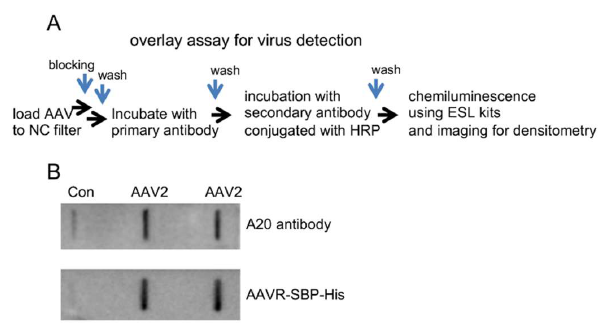
Figure 4. AAVR-SBP-His proteins used for viral overlay assays. ( A ) Assay workflow. AAV particles were loaded to nitrocellulose (NC) filter, probed with AAVR-SBP-His protein or A20 antibody overnight, and then incubated with HRP conjugated SAV or IgG-HRP. ( B ) AAV2 of 1 × 10 9 v.g. subjected to the detection procedure as described in ( A ). PBST buffer was used as a negative control.